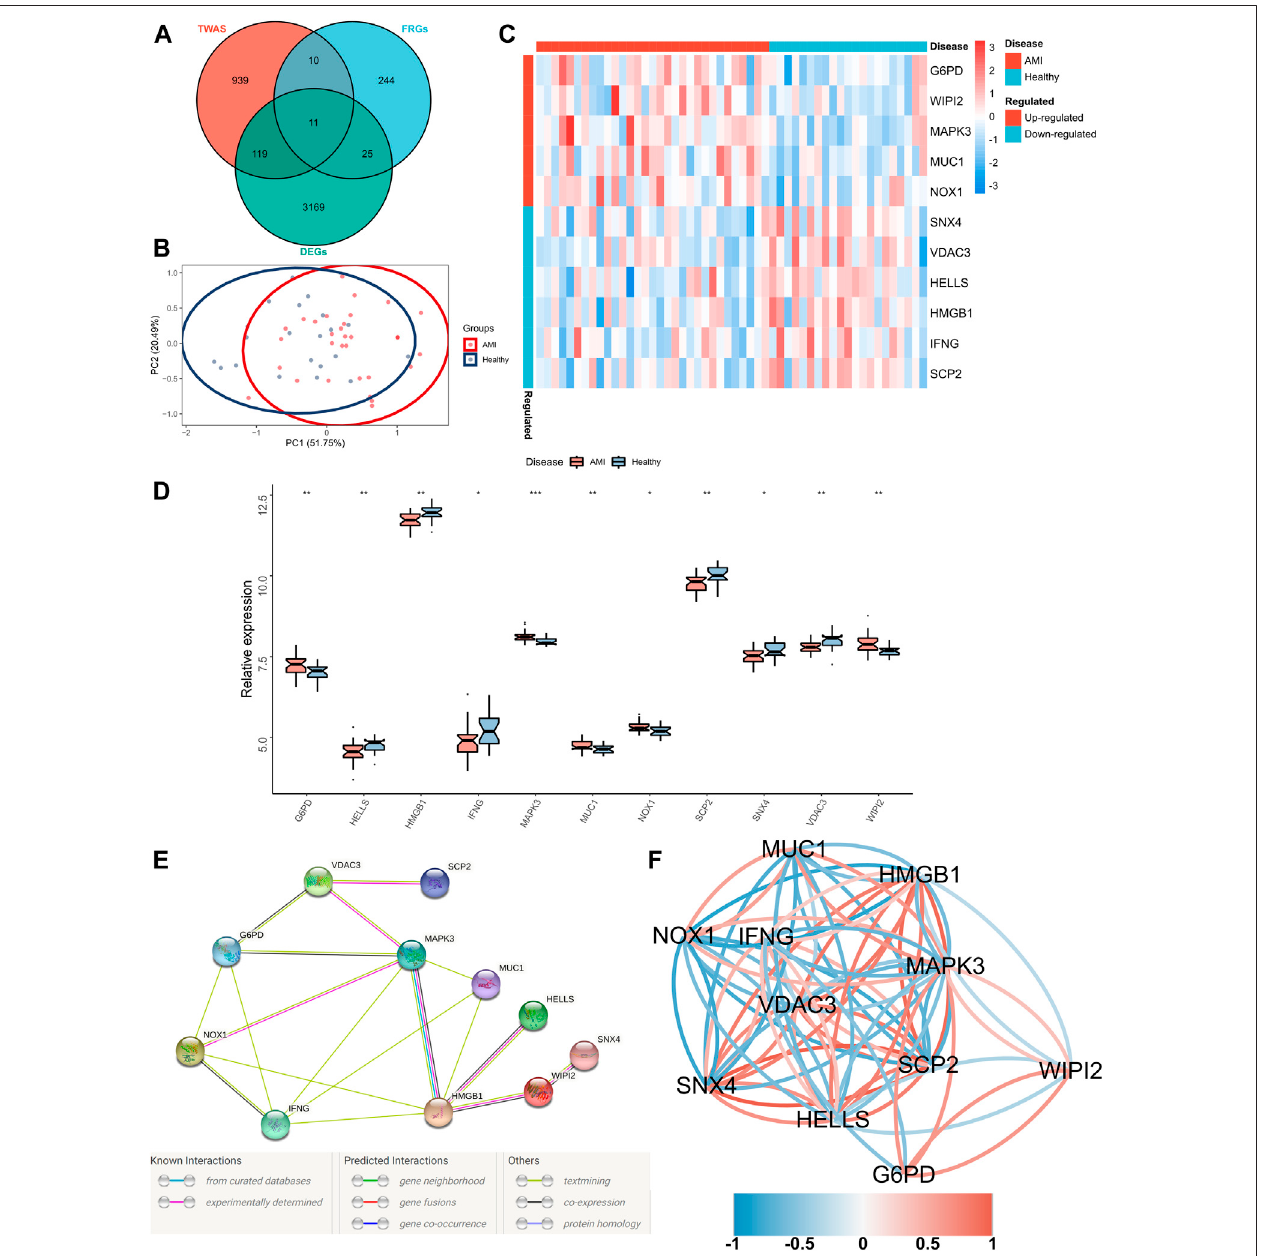
FIGURE2| Identi fi cationofFRGsspeci fi callyexpressedintheperipheralbloodofpatientswithAMI. (A) AVenndiagramshowingtheintersectionofTWASresults, DEGs and obtained FRGs, wherein 11 shared FRGs were identi fi ed; (B) PCA of FRGs showing good differentiation power; (C) A heatmap showing the transcriptional pro fi les of FRGs in AMI samples and healthy controls; (D) Box plots showing differential expressions of FRGs in AMI samples and healthy controls. Wilcoxon test; * p < 0.05, ** p < 0.01, *** p < 0.001; (E) PPI network of FRGs; (F) Correlation network of FRGs.